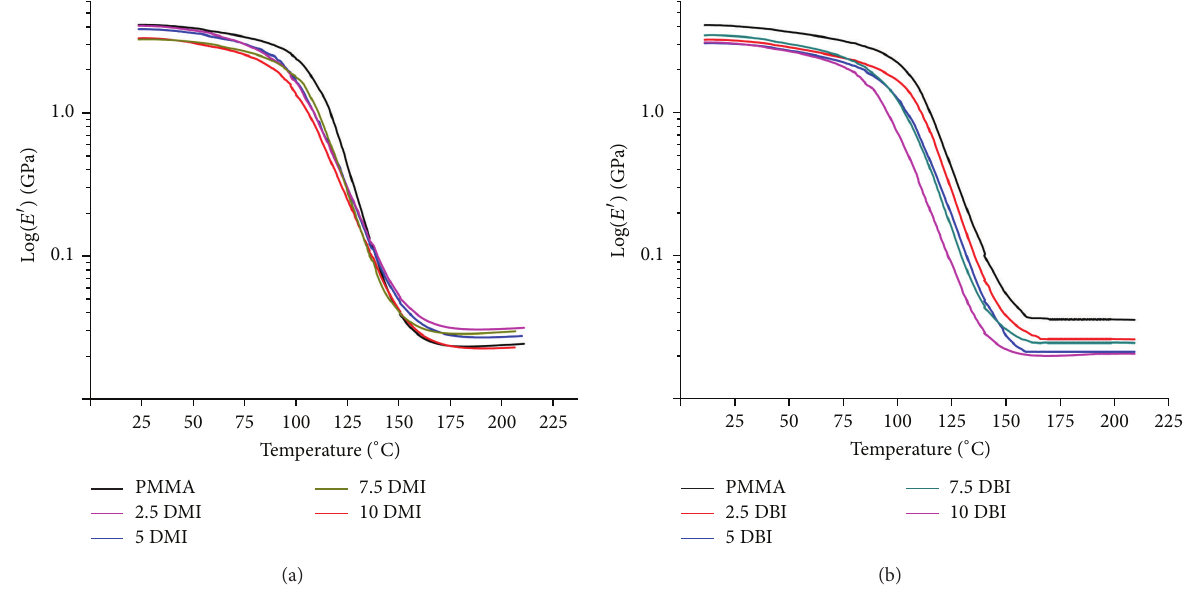
Figure 6: Changes in storage modulus ( E 󸀠 ) over temperature for PMMA denture base materials modified with (a) DMI and (b) DBI.